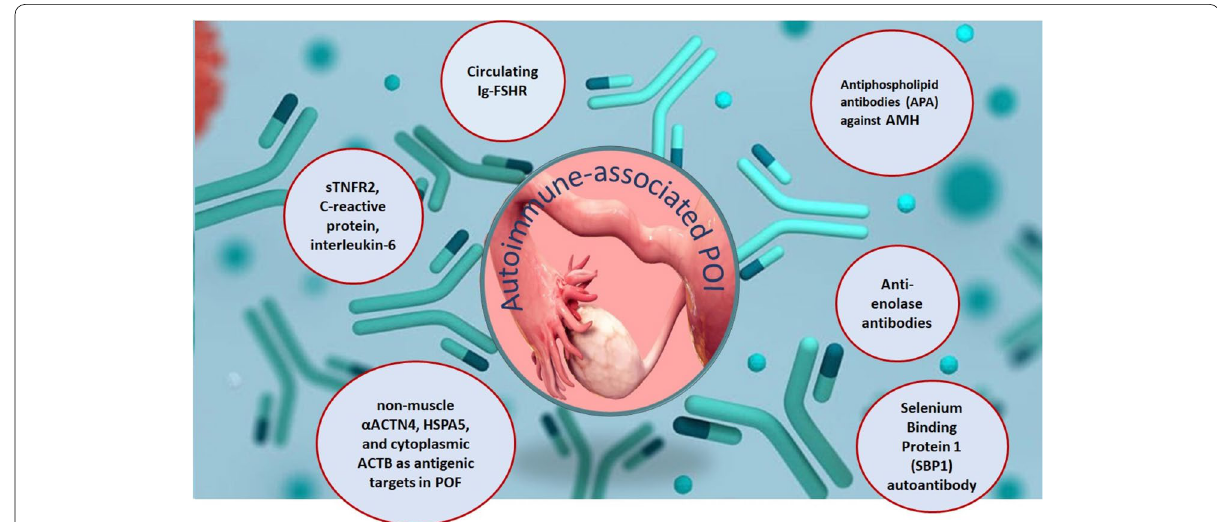
Fig. 1 Suggested factors that may impair ovarian immunoregulation and have a possible role in POI- associated